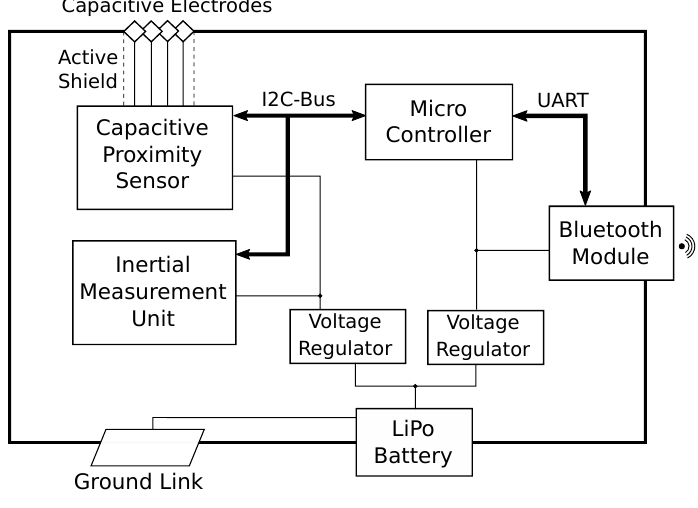
Figure 4. System architecture block diagram.